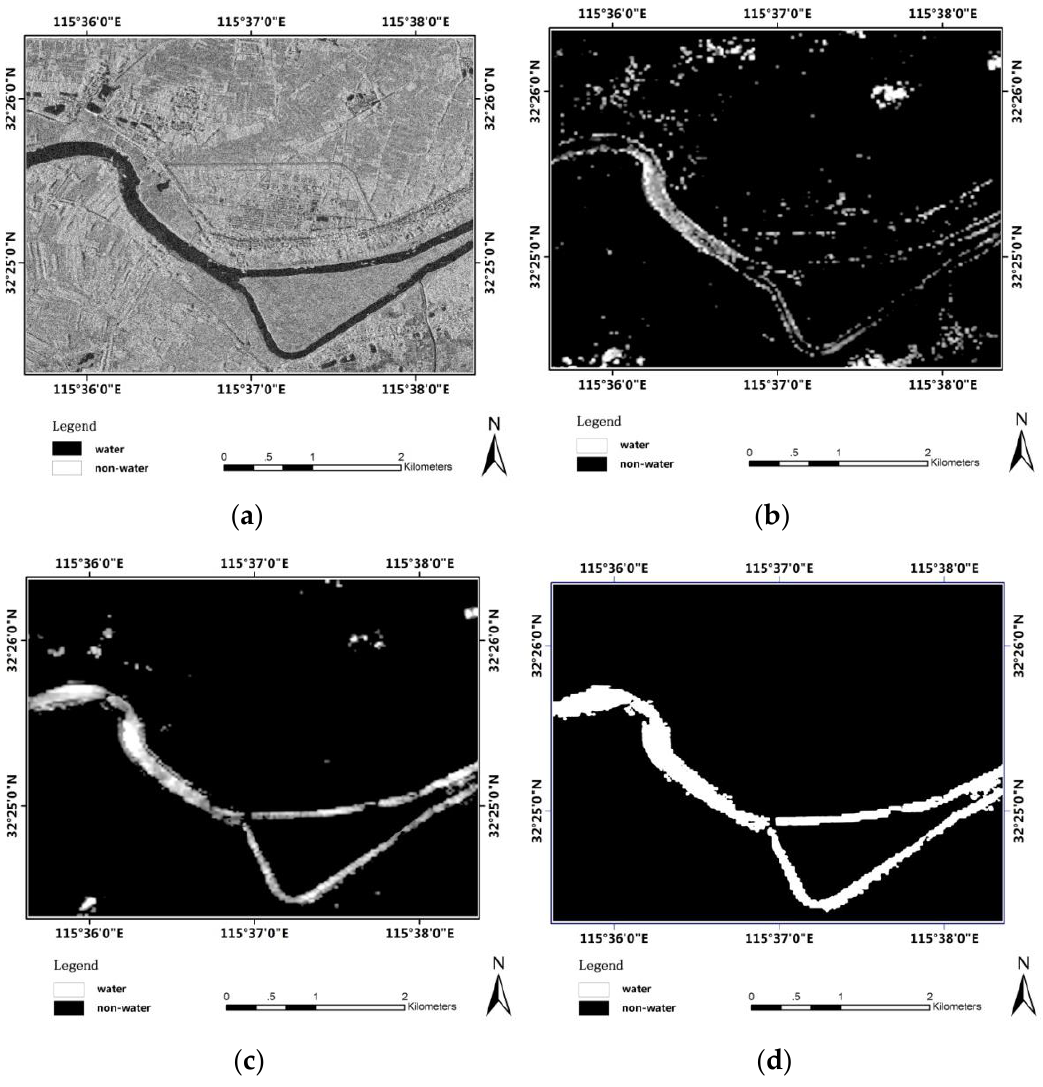
Figure 3. Saliency map comparison (Huai River). ( a ) Original imagery; ( b ) Salience map generated by Itti model; ( c ) Salience map generated by our TW-Itti model; ( d ) Otsu segmentation result after post-processing of image (c).